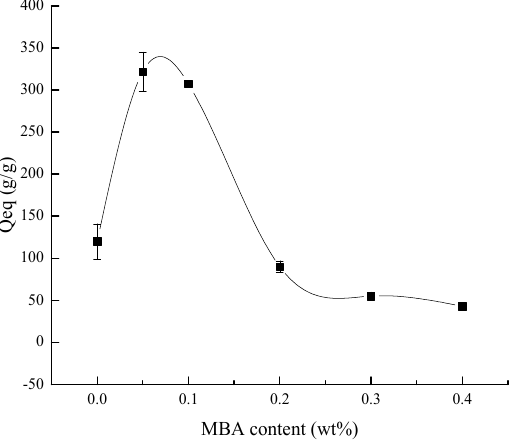
Figure 4. The influence of the ratio of crosslinker content to the monomer content on the water absorbency.